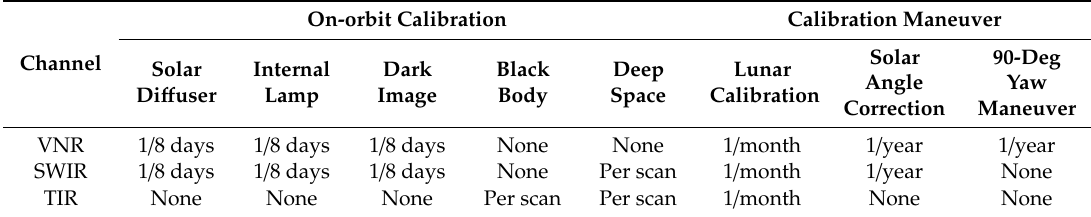
Table 3. Types of calibration conducted on the SGLI